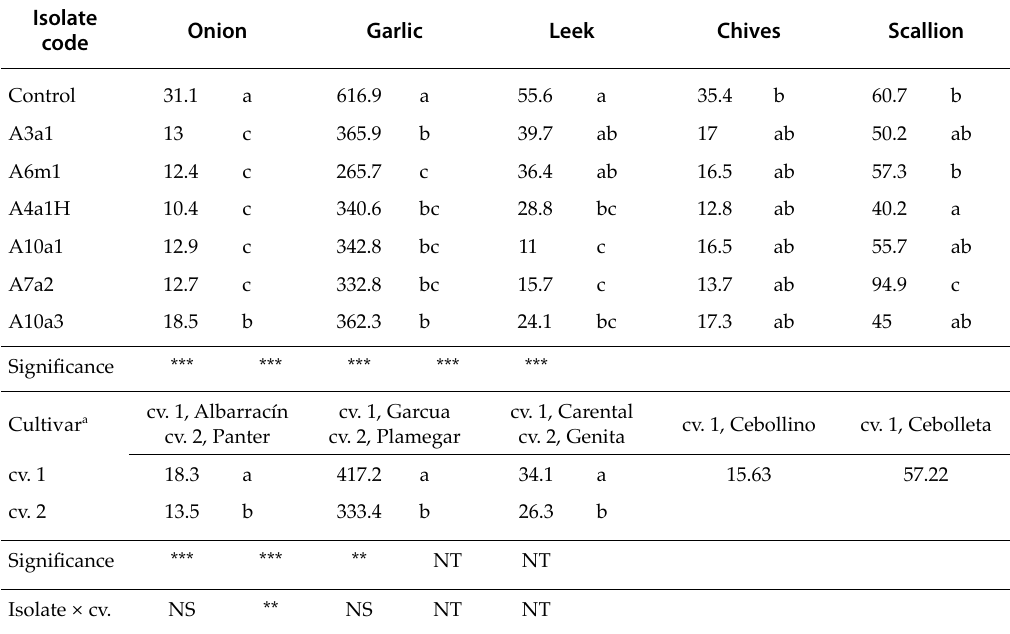
Table 3. Dry weight of onion ( Allium cepa ), garlic ( A. sativum ), leek ( A. porrum ), chives ( A. schoenoprasum) and scallion ( A. fistulosum ) seedlings following artificial inoculation with six isolates of F. proliferatum originating from